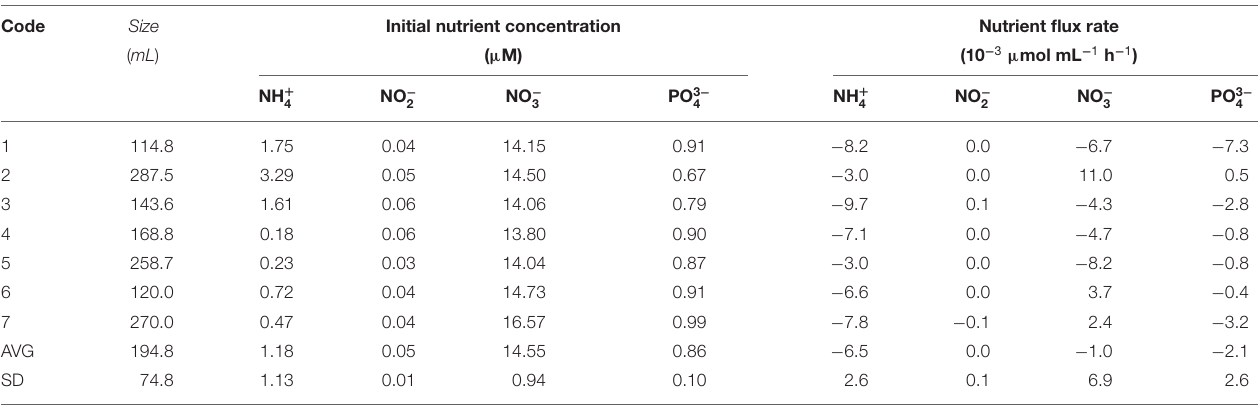
TABLE 1 | Flux of nutrients measured through in-situ incubations of Schaudinnia rosea .